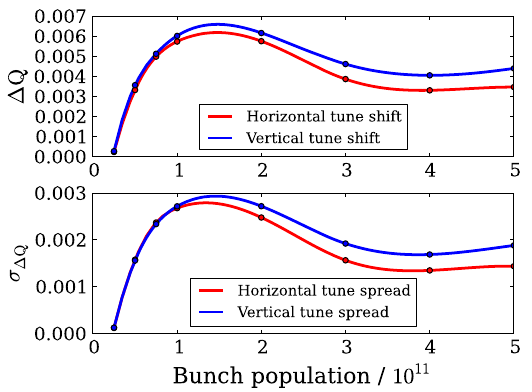
19. Tune shifts (top) and tune spreads (bottom) as a function of bunch population for the LHC geometry. The result for horizontal (red) and vertical (blue) planes is